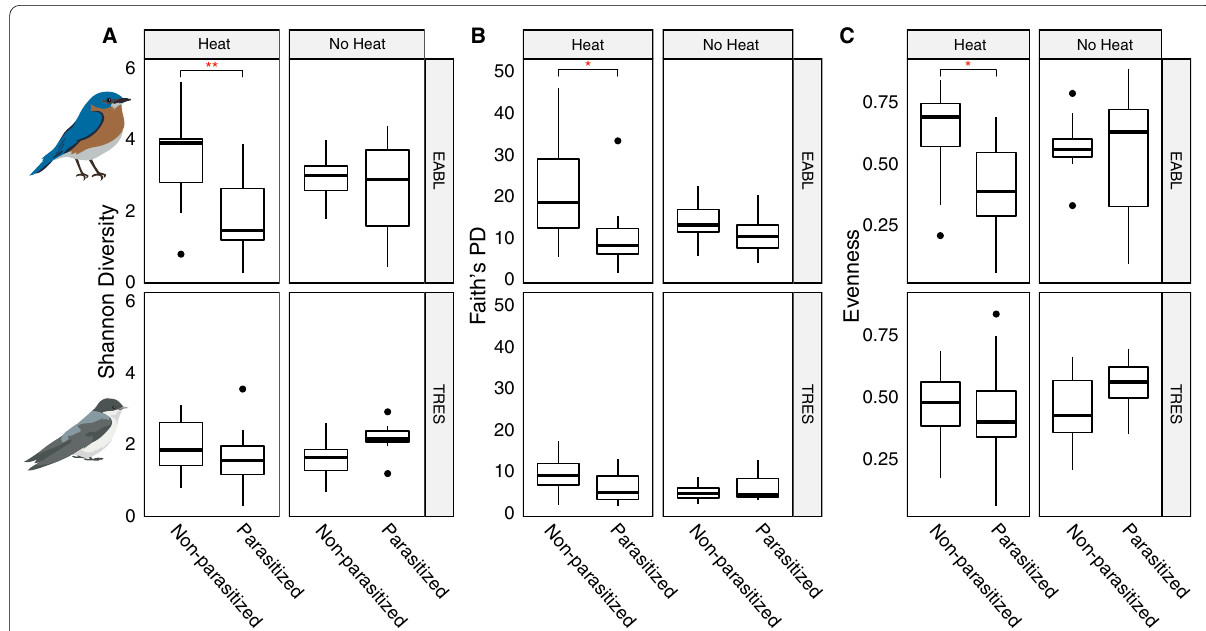
Fig. 4 Effect of heat and parasite treatments on alpha diversity of eastern bluebird and tree swallow nestling microbiotas. Panels depict a ) Shannon diversity, b ) Faith’s phylogenetic diversity, and c ) Evenness. Horizontal bars represent median values while solid points indicate outliers. Significance codes: ** p adj < 0.001, * p adj < = =